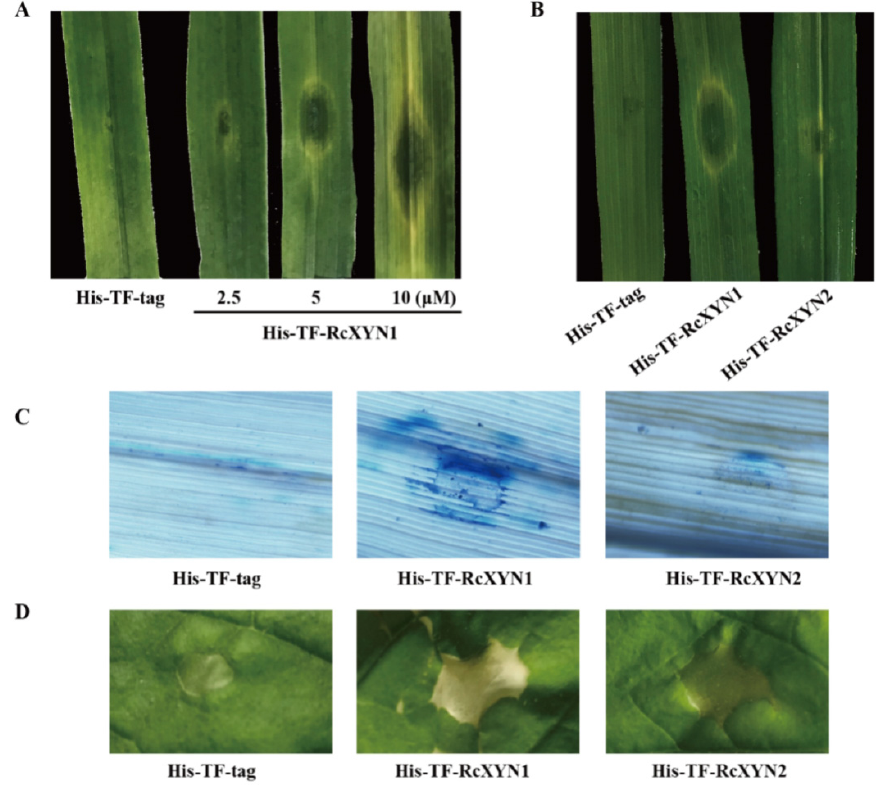
Figure 6. The necrosis and cell death induced by RcXYN1 in wheat and Nicotiana benthamiana leaves. ( A ) Wheat leaves 3 days post infiltration with the His-TF-RcXYN1 (2.5, 5, and 10 µ M) and the His-TF-tag solution (5 µ M) as control. ( B ) Wheat leaves 3 days post infiltration with the His-TF-RcXYN1 (5 µ M) and His-TFRcXYN2 (5 µ M). ( C ) Trypan blue staining of wheat leaves treated with His-TF-RcXYN1 (5 µ M). Dead wheat leaf cells were stained by trypan blue. ( D ) N. benthamiana leaves infiltrated with His-TF-RcXYN1 (5 µ M) and His-TF-RcXYN2 (5 µ M).